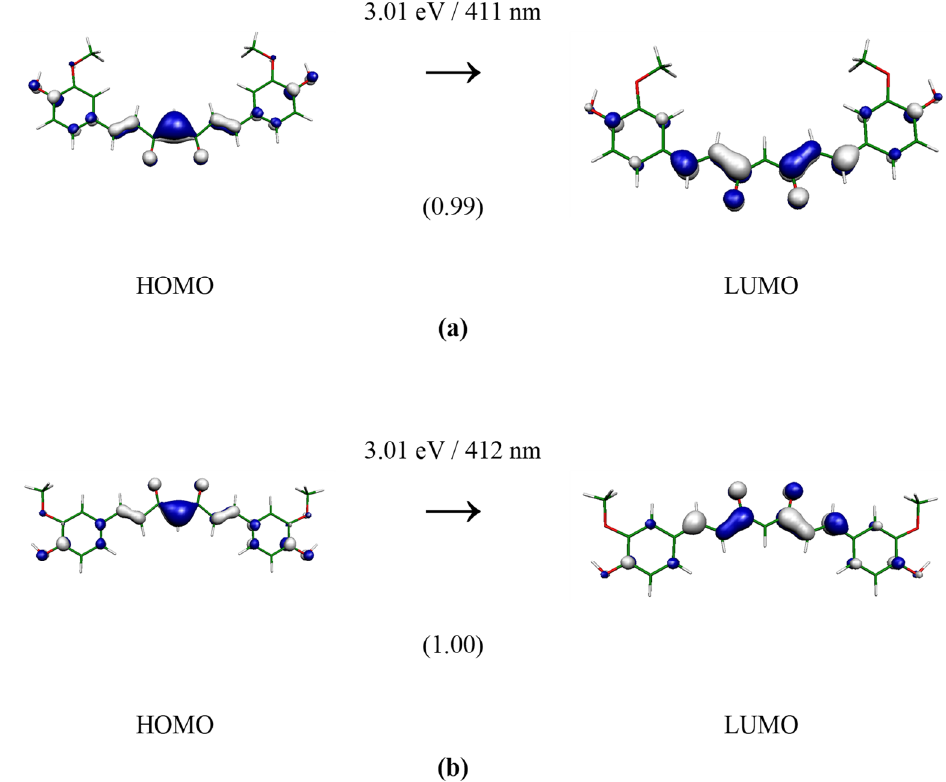
Figure 5. TD-B3LYP(SMD = water)/aug-cc-pVDZ//M062X/cc-pVDZ electron transition forming 1 1 B 1 state of curcumin keto-form IIIa ( a ) and IIIb ( b ) of C 2v group. The depicted orbital isosurface is 0.05 a.u. The oscillator strengths (in atomic units) are in parentheses.